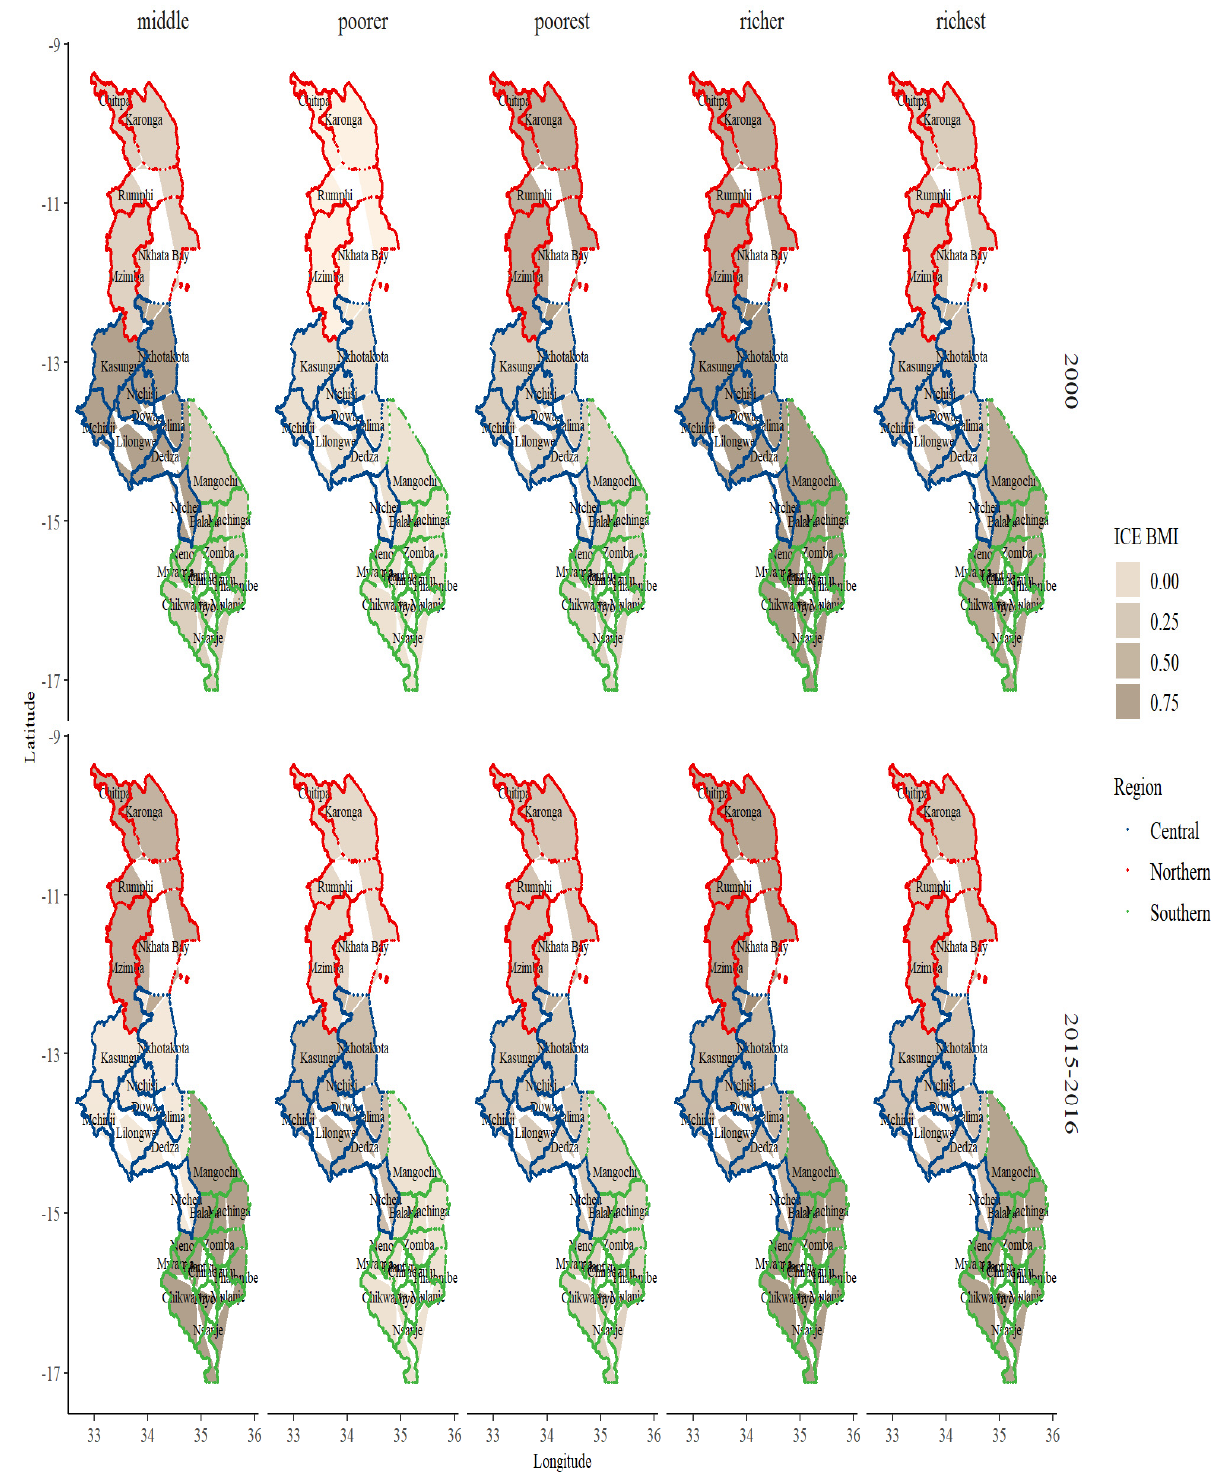
Figure 3. Concentration of extreme body mass index among females. Source: computed from MDHS 2000–2015–2016. Note: BMI: body mass index; red, blue, and green lines represent areas in the northern, central, and southern regions of Malawi.